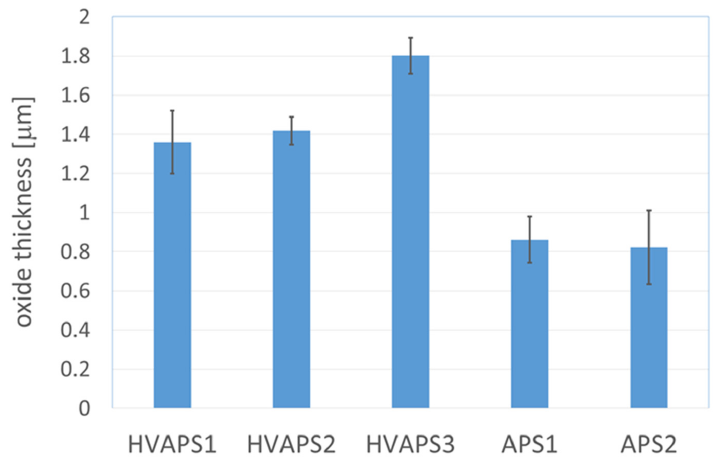
Figure 8. Thickness of the oxide layer after 5 × 20 h cycles at 1300 °C for the different